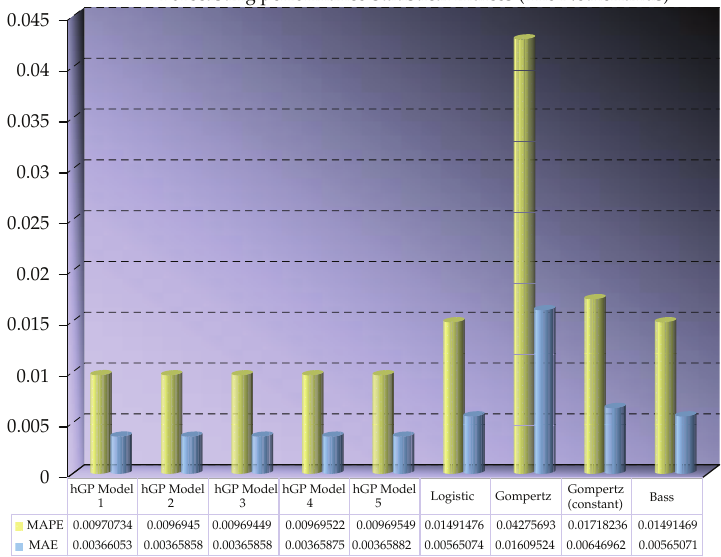
Figure 25: The forecasting performance of the models for The Netherlands (cid:2) forecast period—2 years ahead (cid:3) .